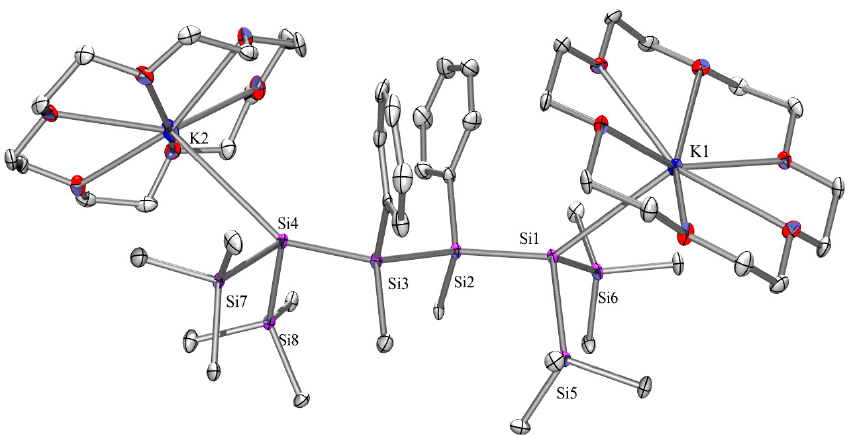
Figure 17. Crystal structure of 18a . Thermal ellipsoids are represented at the 30% level and hydrogen atoms have been omitted for clarity (bond lengths in Å, angles in deg). Si(1)-Si(5) 2.3449(19), Si(1)-Si(6) 2.350(2), Si(1)-Si(2) 2.360(2), Si(1)-K(1) 3.5079(19), Si(2)-C(1) 1.908(5), Si(2)-Si(3) 2.3734(17), Si(5)-Si(1)-Si(6) 99.17(7), Si(5)-Si(1)-Si(2) 106.41(7), Si(6)-Si(1)-Si(2) 98.25(7), Si(1)-Si(2)-Si(3) 117.41(7), Si(2)-Si(3)-Si(4) 115.99(7), Si(7)-Si(4)-Si(8) 96.39(7), Si(7)-Si(4)-Si(3) 99.23(8), Si(8)-Si(4)-Si(3) 104.83(7).